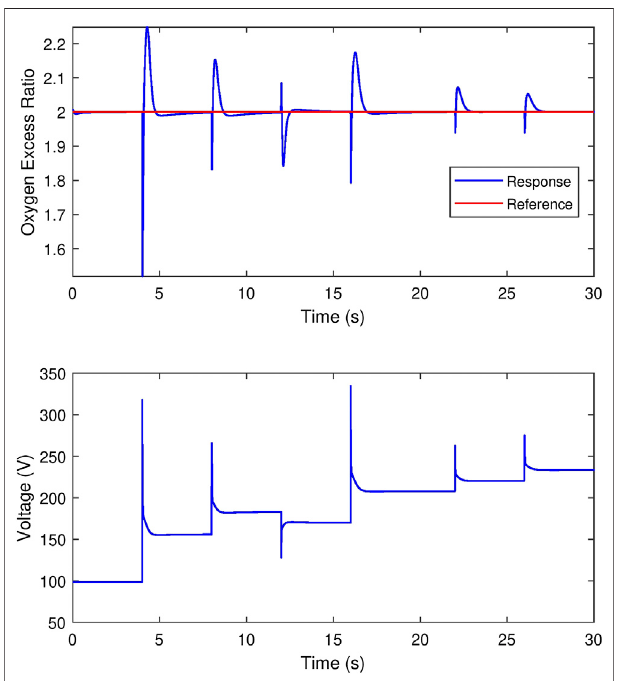
FIGURE 6 | OER regulation using GP controller for excursion minimization.